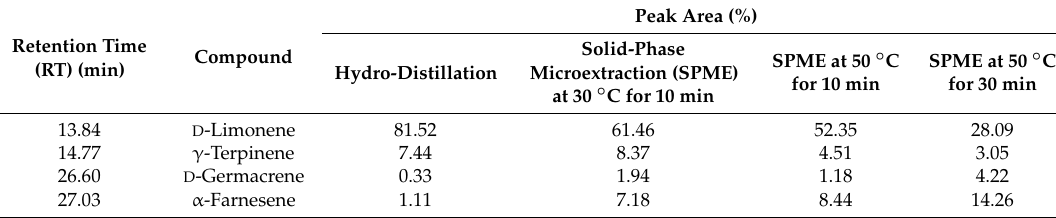
Figure 1. GC-MS typical total ion chromatograms (TICs) of volatile compounds in the “Chenpi” (CP) sample (S5). ( a ) Extracted through hydro-distillation. ( b ) Extracted through headspace solid-phase microextraction (HS-SPME) at 30 ° C for 10 min. ( c ) Extracted through HS-SPME at 50 ° C for 10 min. ( d ) Extracted through HS-SPME at 50 ° C for 30 min. Table 1. Main terpenes identified in the analyzed “Chenpi” (CP) sample (S5) using various extraction methods and parameters.